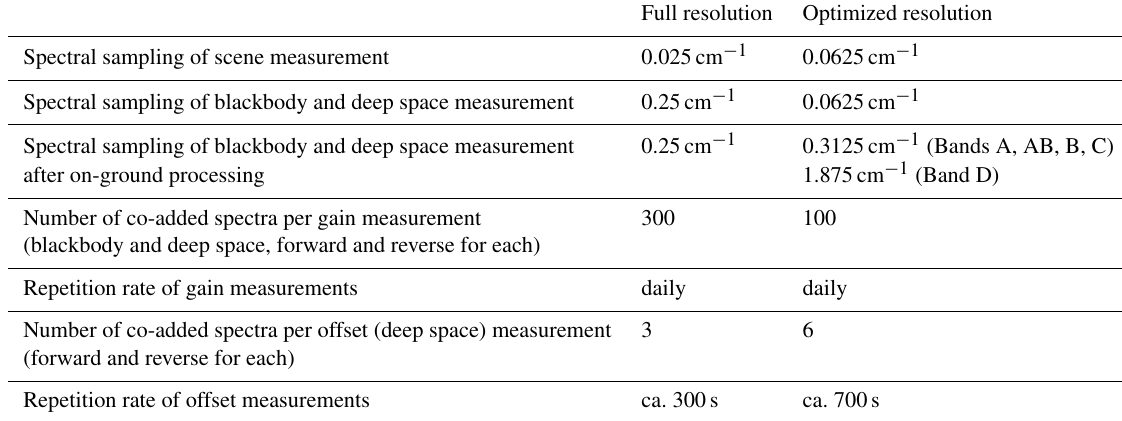
Table 1. Radiometric calibration measurements Spectral sampling of scene measurement 0.025cm − 1 0.0625cm − 1